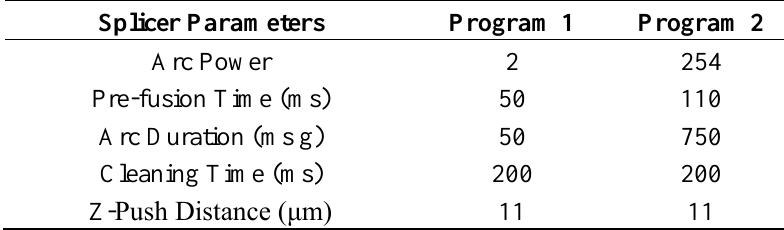
Table 1. Set of Parameters for Splicer Programs 1 and